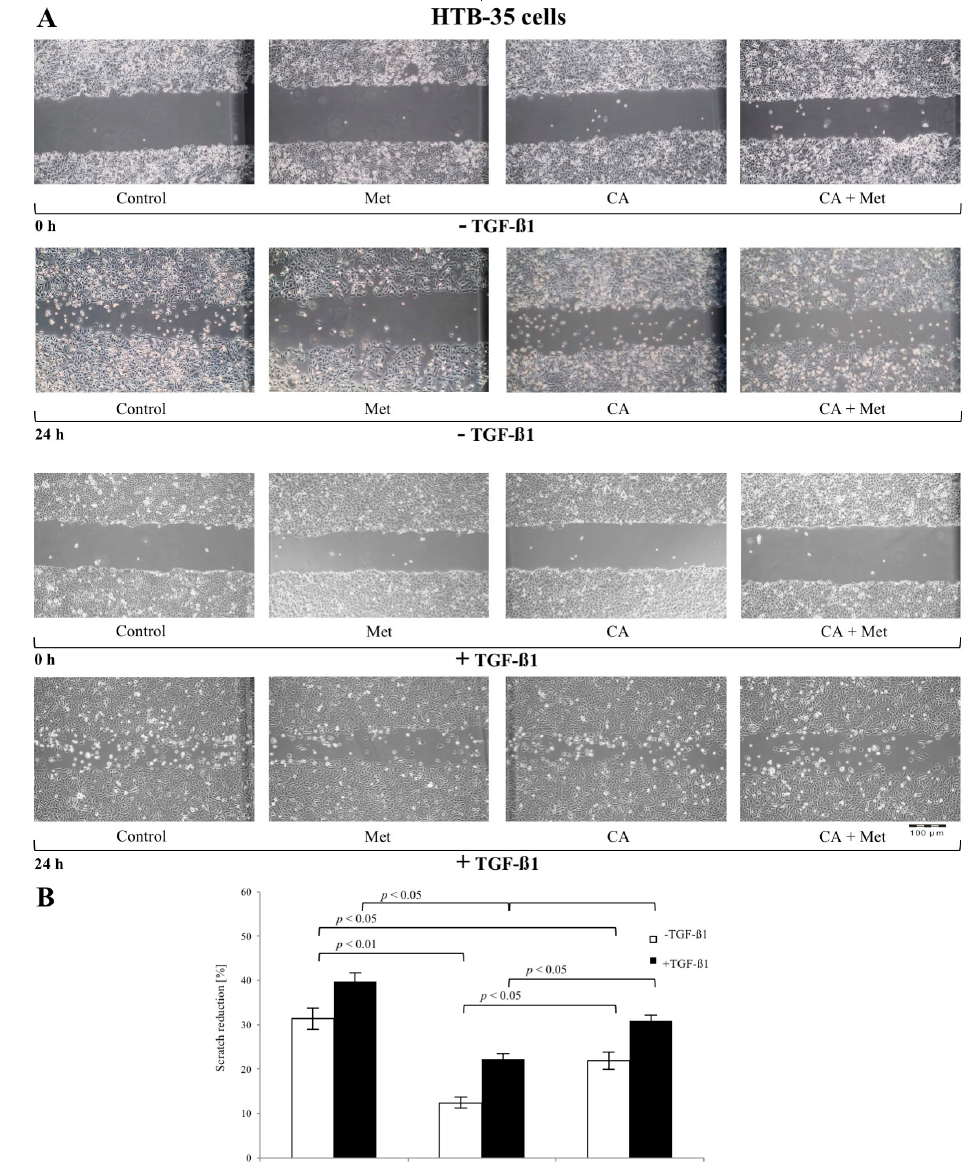
Figure 3. The effect of Caffeic Acid (CA) and Metformin (Met) on HTB-35 cells migration in vitro ( A , B ). HTB-35 cells were cultured to sub-confluency and then an injury line was made on the monolayer of cells. Then the cells were incubated with addition of tested compounds (CA at 100 μ M and/or Met at 10 mM) and with/without 10 ng/mL TGF- β 1 for 24 h. Representative images of the scratch assay conducted on the HTB-35 cell line following treatment of cells with CA at concentration of 100 μ M, Met at 10 mM or both compounds were presented. The images were captured at 0 and 24 h after scratching ( A ). The effect of CA and/or Met on cell motility was determined by wound healing assay and presented as reduction of each scratch after 24 h of incubation (( A ), the Image J program was used to analyze the changes in each wound area; Image J v1.44; National Institutes of Health, Bethesda, MD, USA). Note that Met exerted greater effect than CA (( B ), p < 0.05 for CA vs. Met) and CA/Met in HTB-35 cell line (( B ), p < 0.05 for Met vs. Met/CA). Data shown here were from a representative experiment repeated three times with similar results ( A , B ). Quantification of the scratch assay experiments are presented as mean values ± SD ( B ).